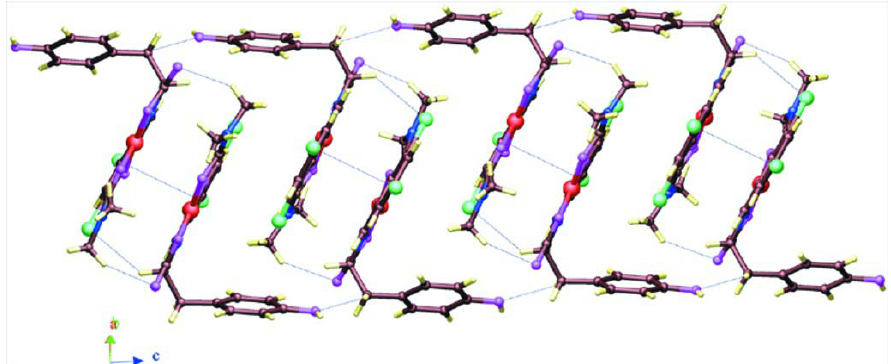
Figure 2 The formation of one-dimensional chains along c . Hydrogen bonds are drawn as dashed